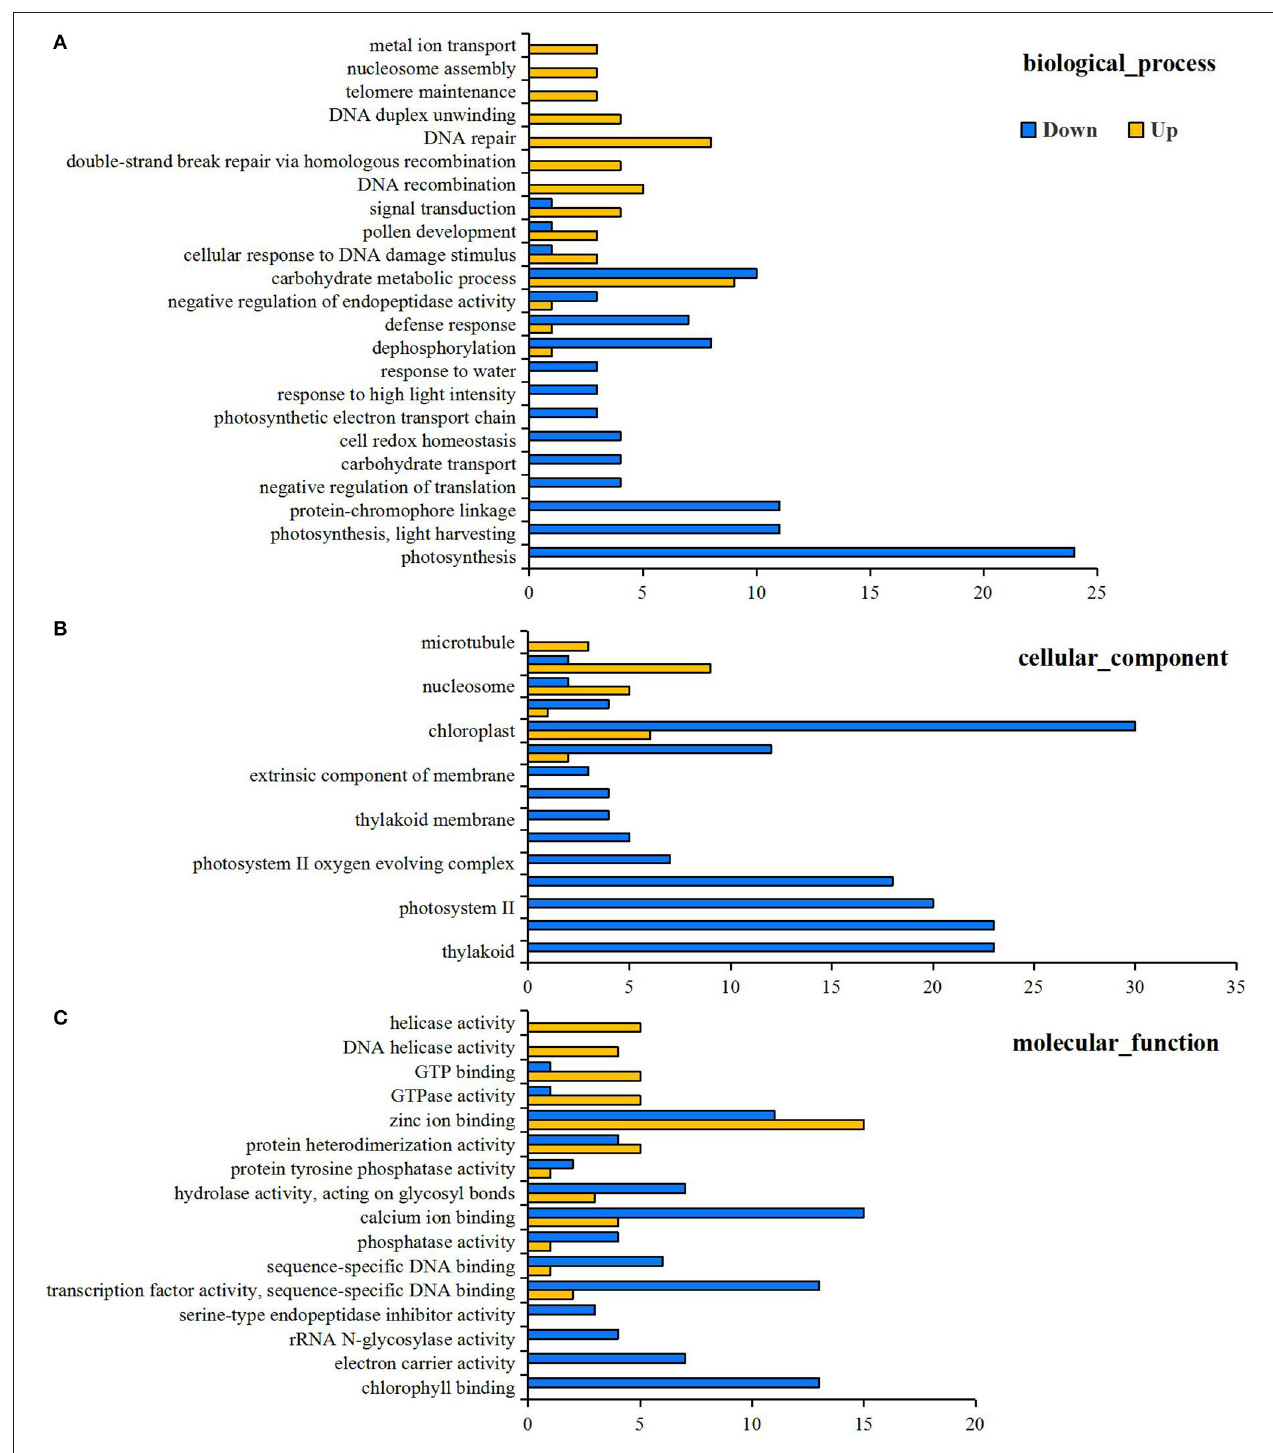
FIGURE 3 | GO classifications of differentially expressed genes (DEGs) for mid-filling grain under N0 and Nck conditions, including three categories (A) biological process, (B) cellular component, and (C) molecular function. Yellow columns represent up-regulated items, and blue columns represent down-regulated items. The x-axis is the amount of DEGs involved related biological process, cellular component and molecular function.